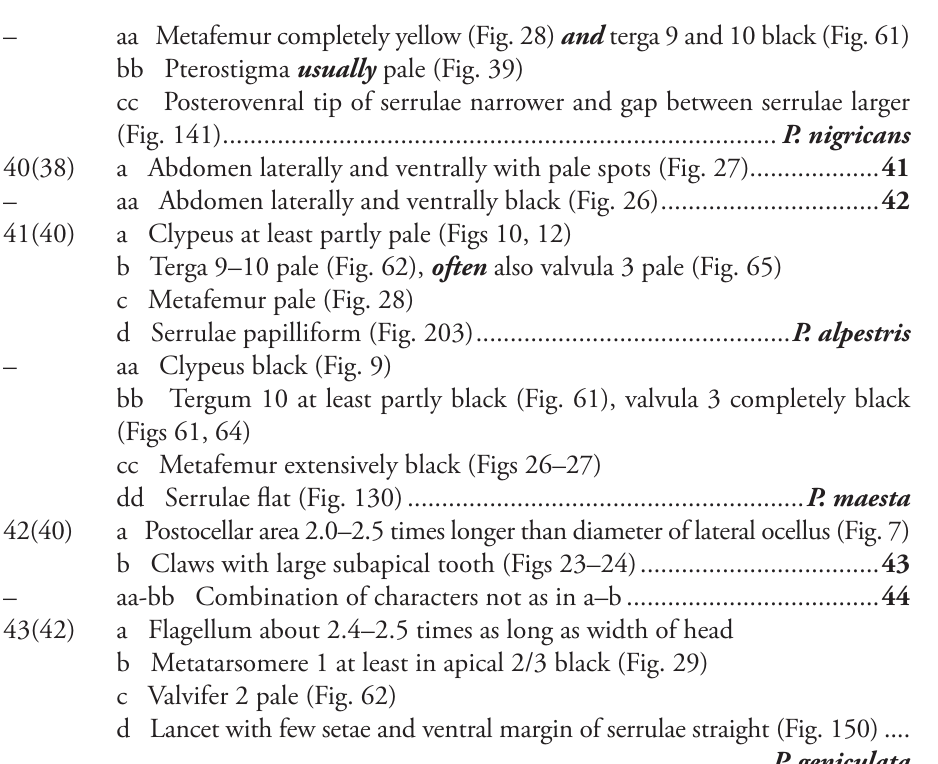
d Lancet with few setae and ventral margin of serrulae straight (Fig. 150)